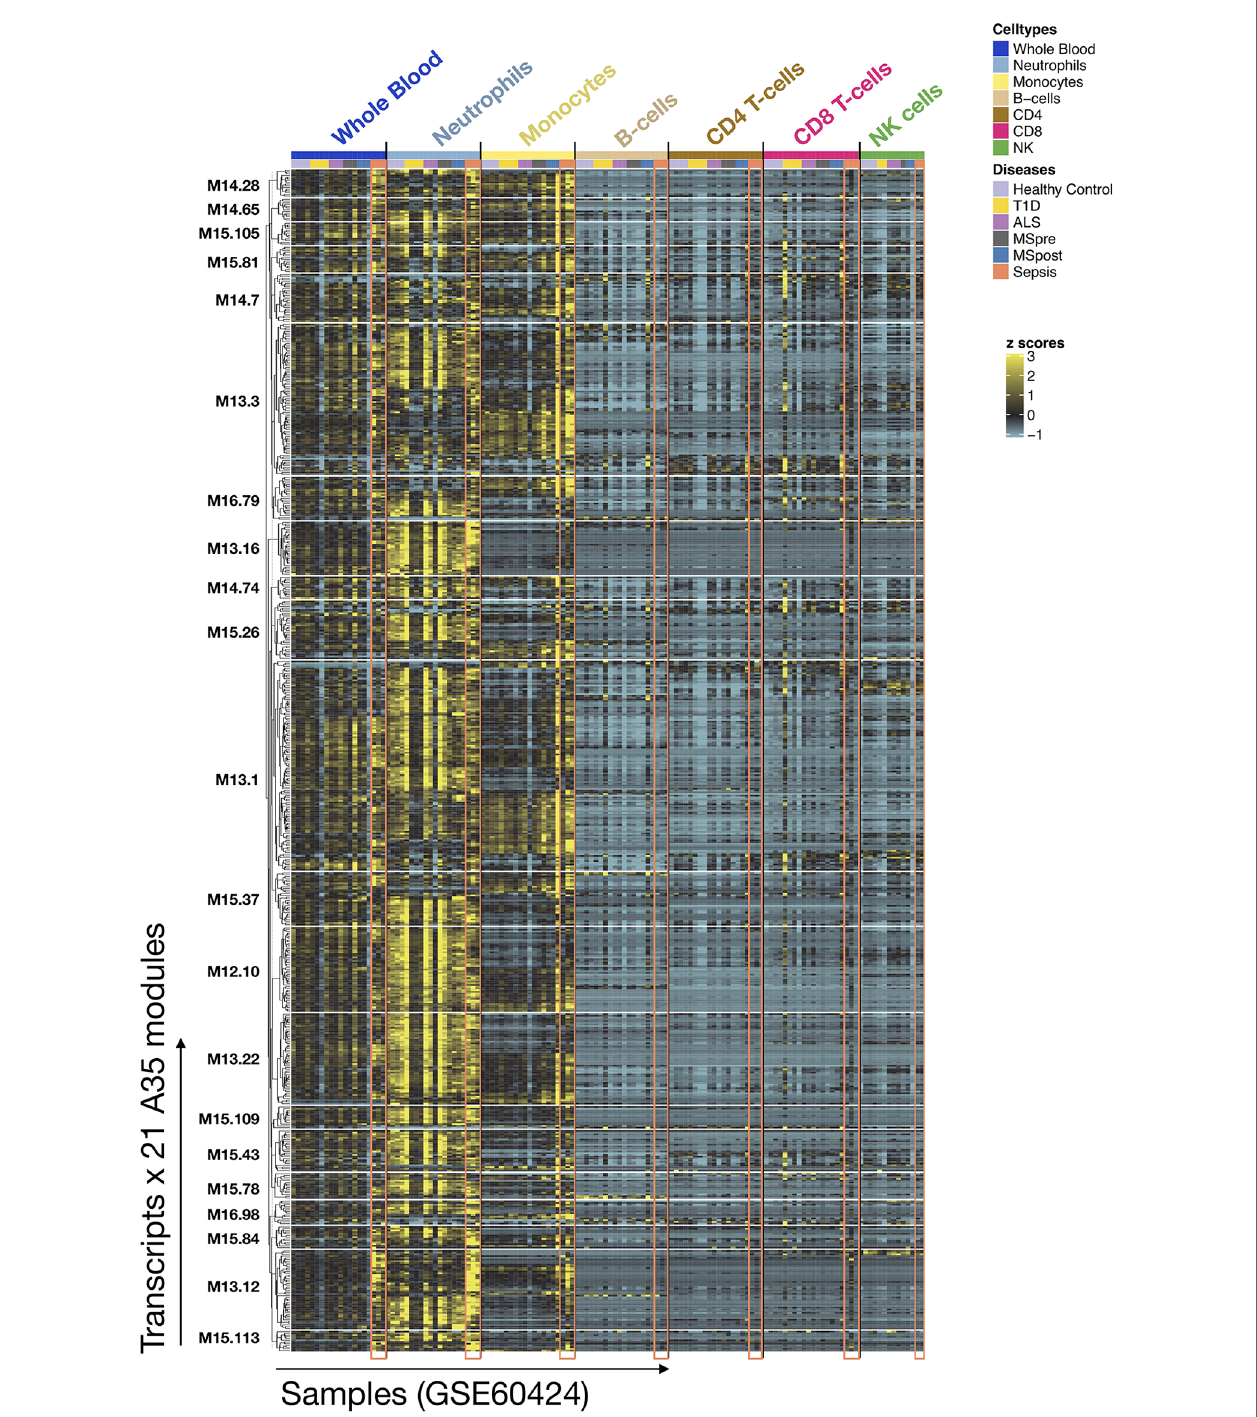
FIGURE 3 | Expression patterns of genes constituting A35 modules across whole blood and puri fi ed leukocyte populations. The expression levels for genes constituting A35 modules are shown on a heatmap for a reference dataset comprising the pro fi les of isolated leukocyte populations (GSE60424). The rows represent genes, with each cluster of rows representing a module. The columns represent samples. This study compared the whole transcriptome signatures of six immune- cell subsets and whole blood from patients with one of an array of immune-associated diseases. Fresh blood samples were collected from healthy subjects and those diagnosed with type 1 diabetes, amyotrophic lateral sclerosis, sepsis, or multiple sclerosis (before and 24 h after the fi rst dose of IFN-beta). RNA was extracted from each of the indicated cell subsets and whole blood samples, and then processed for RNA sequencing (Illumina TruSeq; 20M